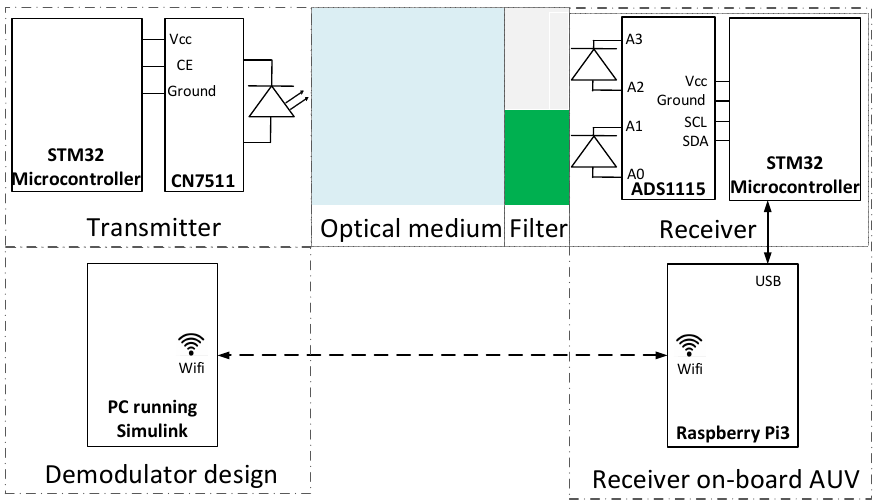
Figure 3. Transmitter receiver functional